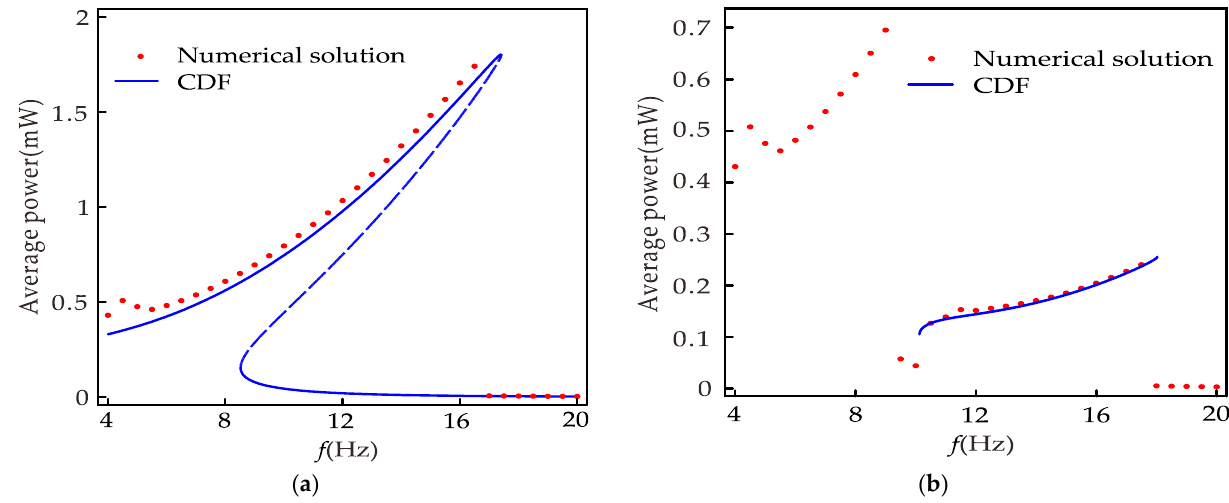
Figure 9. Average power versus frequency with p = 9 m/s 2 , d = 24 mm, R L = 1000 k Ω : ( a ) nonlinear system (primary resonance); ( b ) nonlinear system (1/3 subharmonic resonance).